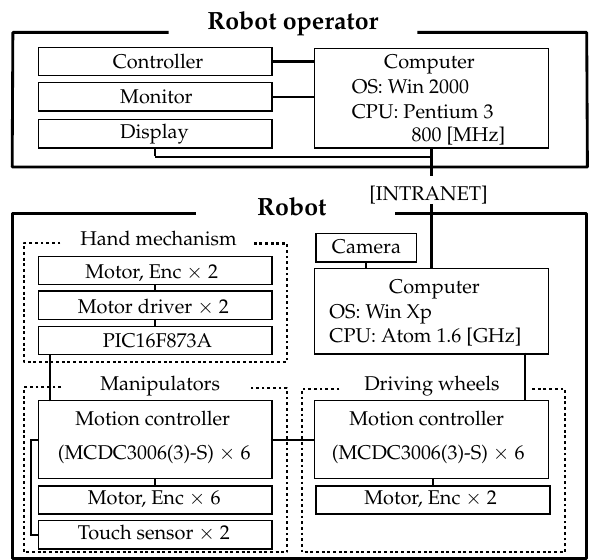
Figure 14. Block diagram of the robot system.